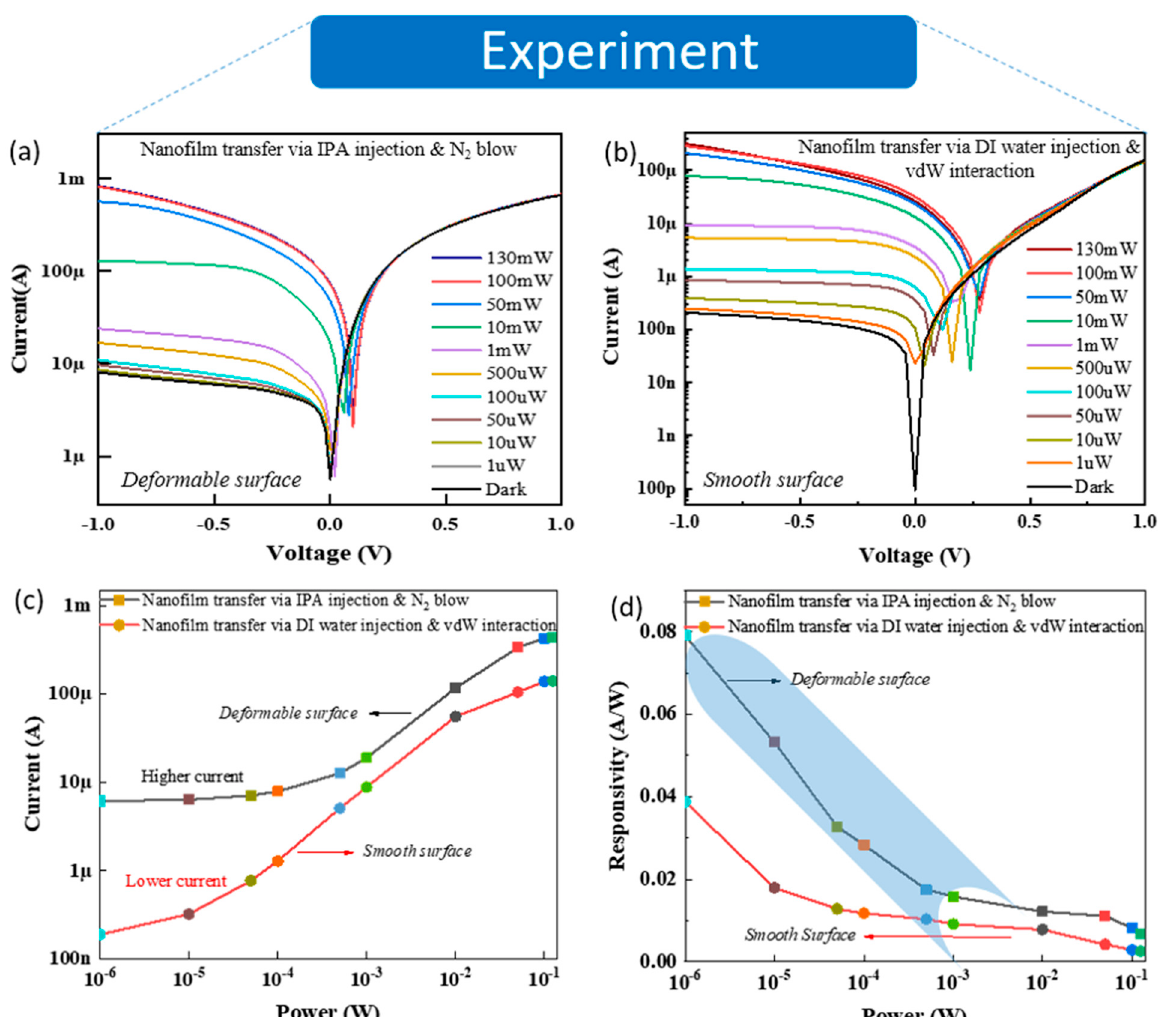
Figure 2. I–V curves of various laser powers measured on two different nanofilm-based photodetection devices using two transfer methods: ( a ) IPA injection and N 2 blowing (deformable surface) and ( b ) DI water injection and vdW interaction (smooth surface). ( c ) Current and ( d ) responsivity of V = − 1 V as the functions of different powers using a visible wavelength laser of the two transferred-nanofilm-based devices above.